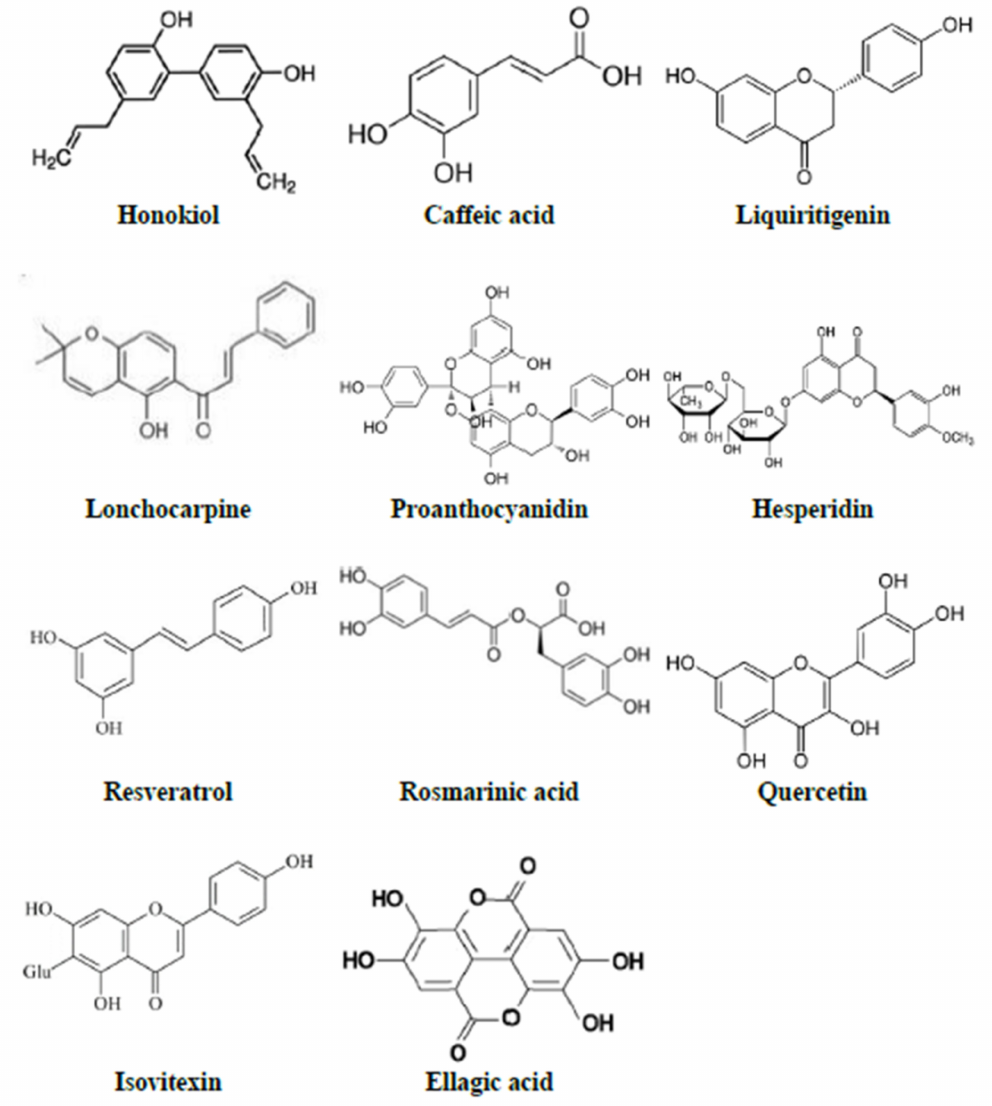
Figure 5. Phenolic or polyphenolic compounds effective against LPS-induced sickness behaviour in